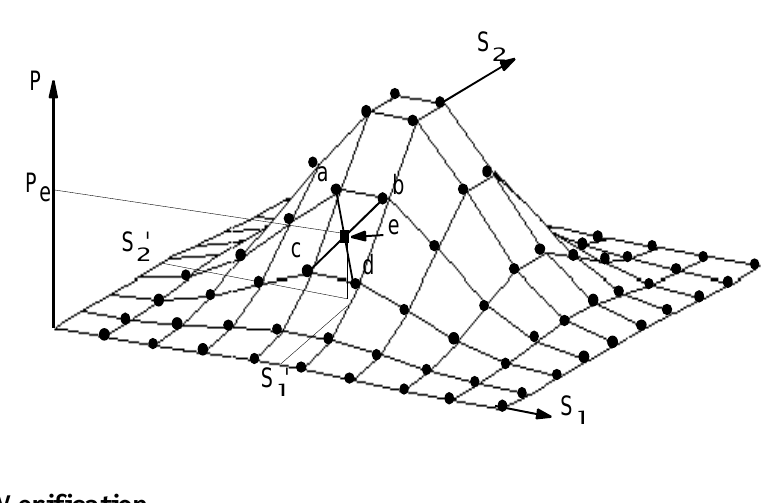
Figure 10. Interpolation by the PLNN.